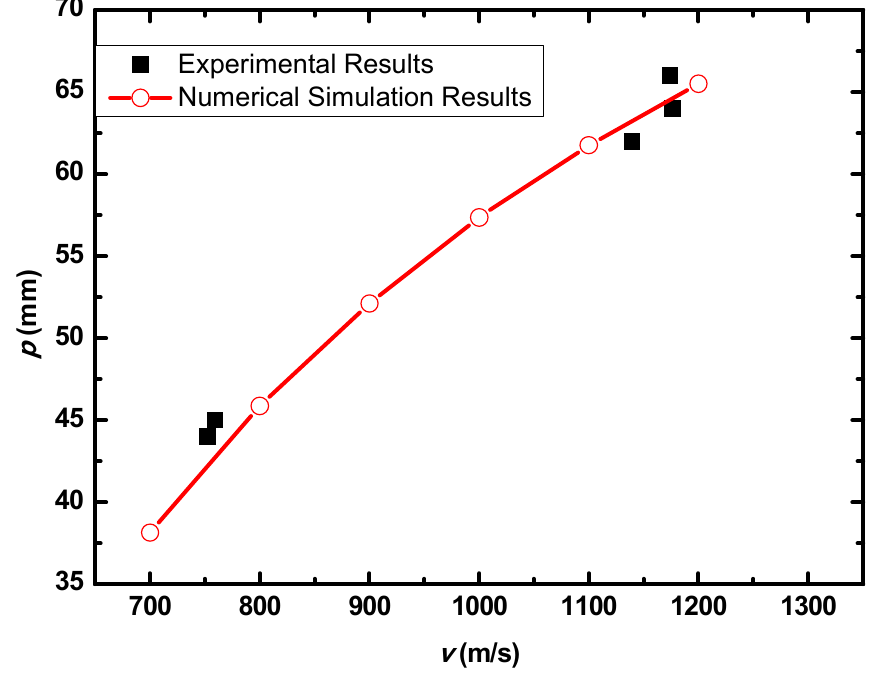
Figure 10. p–v curve of the blunt projectile penetration into the armor with two layers of PE. Table 11. Ballistic impact results of armor with three layers of PE.